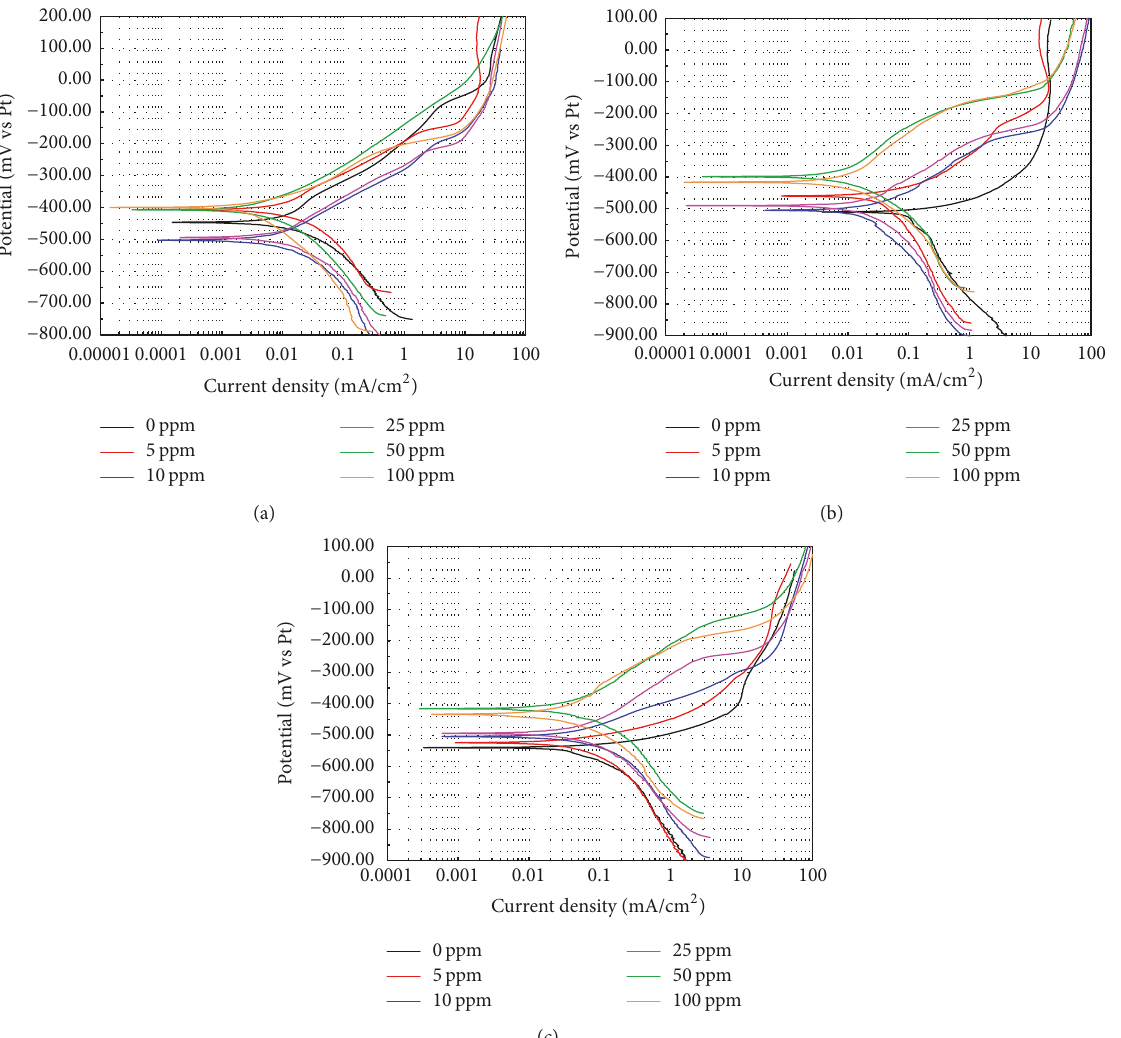
Figure 7: Potentiodynamic polarization curves for API X-70 steel in CO 2 -saturated saline solution at different concentrations of inhibitor: (a) 30 ∘ C, (b) 50 ∘ C, and (c) 70 ∘ C, after 24 hours of